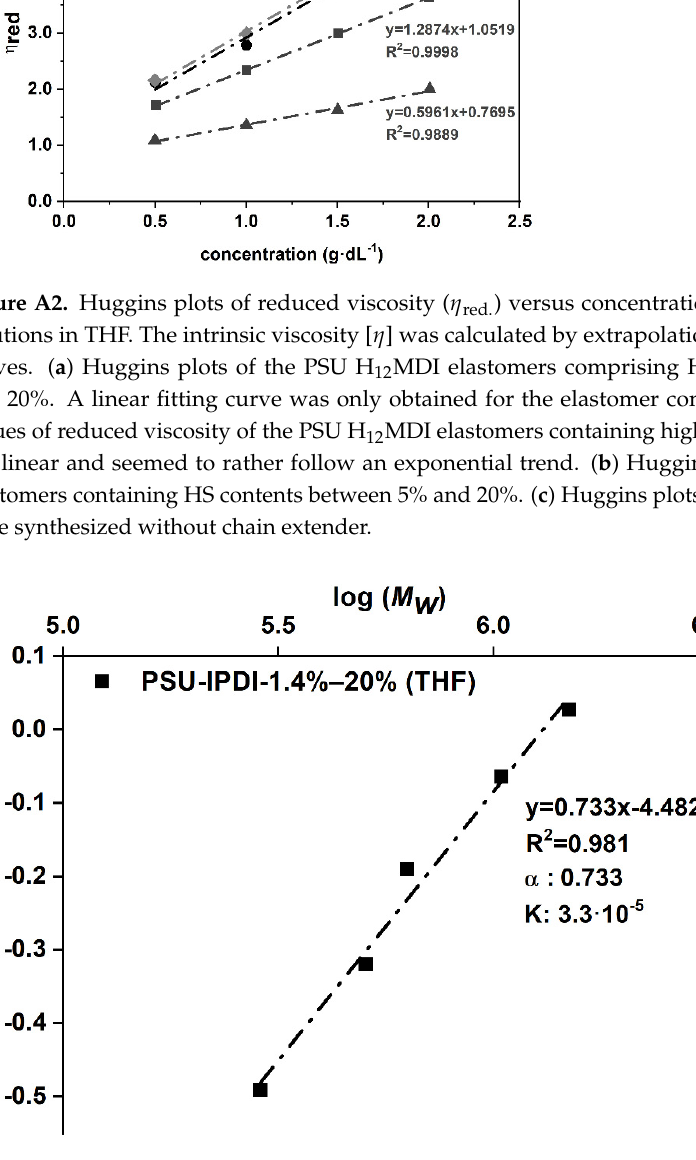
Figure A3. Double logarithmic plot of intrinsic viscosity [ η ] versus weight average molecular weight M w of the PSU IPDI elastomers determined from SEC. The Mark–Houwink parameters α and K were obtained as slope and intercept from the linear fitting curve, and were 0.733 and 3.3 × 10 − 5 , respectively.